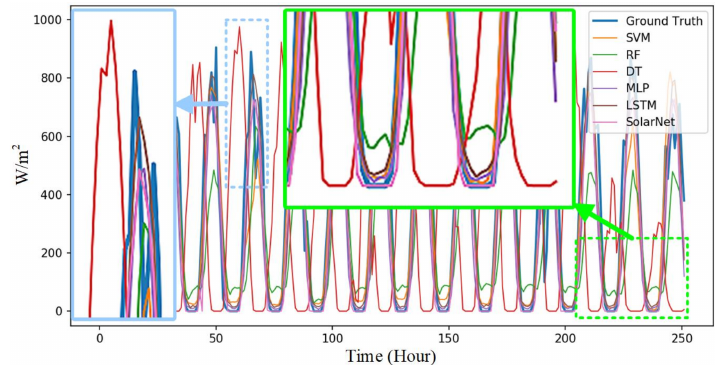
Figure 15. Comparison of forecasting